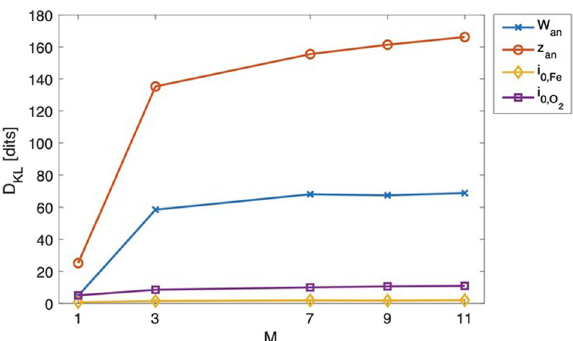
Fig. 2 Information gain upon increasing the number of different cases of external polarization. The information gain (Kullback − Leibler divergence) D KL , for the four model parameters, for an increasing number of different cases of external polarization ( M ). For M = 3, the applied current I CE = [ − 0.2, 0, 0.08] mA. For M = 7, I CE = [ − 0.2, − 0.08, − 0.02, 0, 0.02, 0.04, 0.08] mA. For M = 9, I CE = [ − 0.2, − 0.08, − 0.04, − 0.02, 0, 0.02, 0.03, 0.04, 0.08] mA. And fi nally for M = 11, I CE = [ − 0.2, − 0.08, − 0.04, − 0.02, − 0.008, 0, 0.008, 0.02, 0.03, 0.04, 0.08]